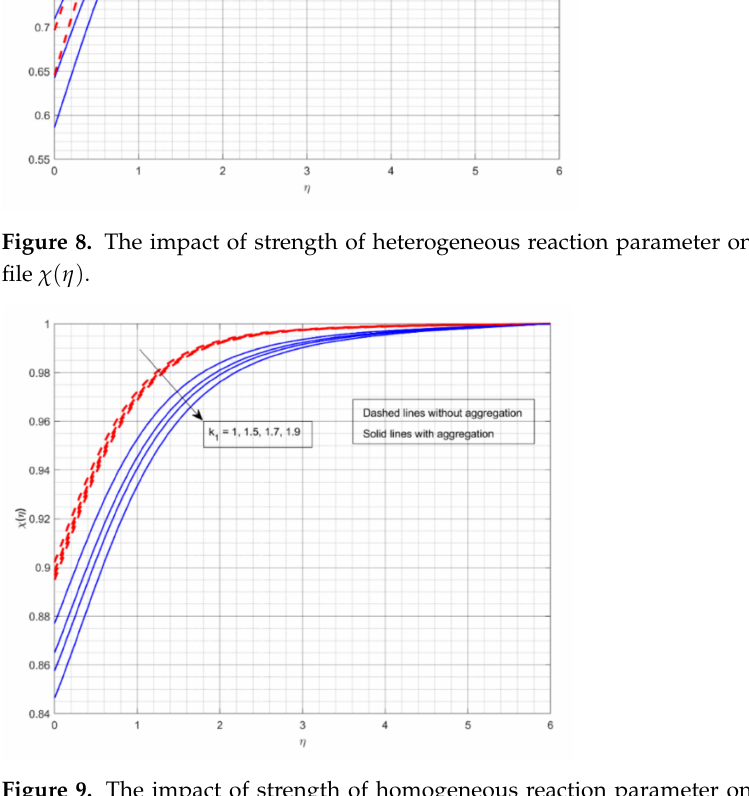
Figure 9. The impact of strength of homogeneous reaction parameter on the concentration pro- file χ ( η ) .